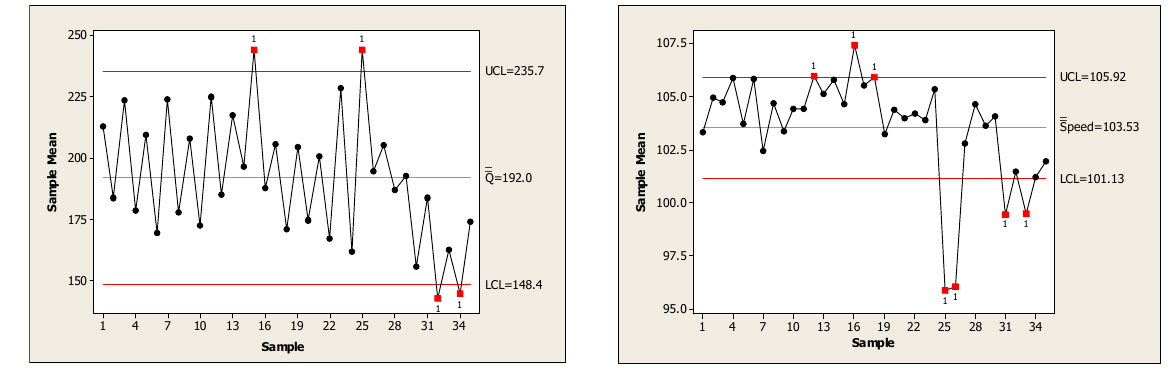
Fig. 4. Flow Control Chart in Phase 1 Fig. 5. Speed Control Chart of in Phase